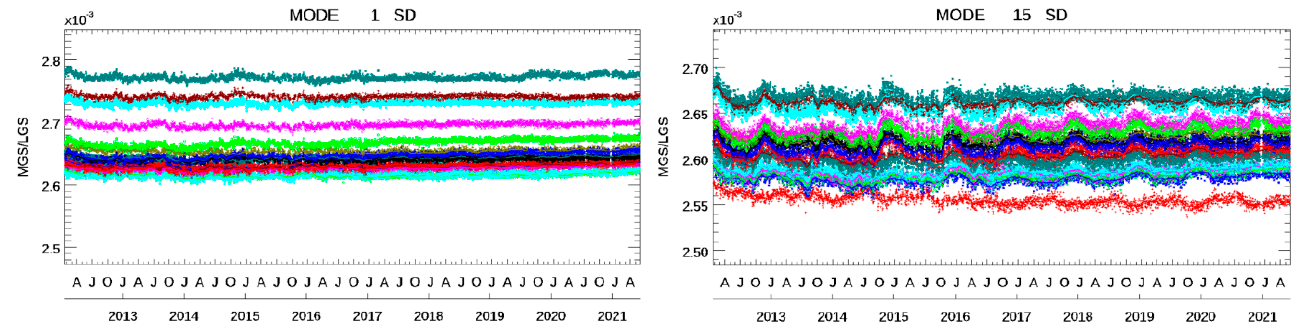
Figure 3. DNB daily averaged LGS F-factor trending at two aggregation modes (mode-1 and mode-15). Different colors are used to plot the DNB 16 detectors.